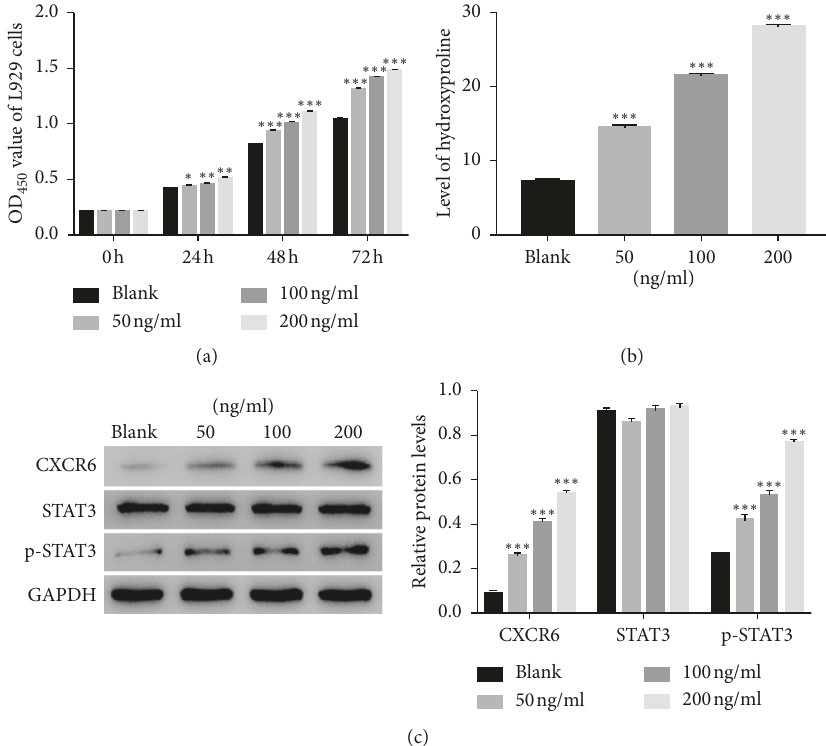
Figure 4: The mouse recombinant protein of CXCL16 contributed to the growth of mouse LF cells. (a) Cell proliferation was detected at 0, 24, 48, and 72hours after being cultured by mouse recombinant protein CXCL16 with different concentration as indicated ( ∗ p < 0 . 05 vs Blank, ∗∗ p < 0 . 01 vs Blank, ∗∗∗ p < 0 . 001 vs Blank). (b) The production of HYP was promoted in mouse LF cells that were cultured by mouse recombinant protein of CXCL16 with different concentrations as indicated ( ∗∗∗ p < 0 . 001 vs Blank). (c) The protein level of CXCR6, STAT3, and p-STAT3 was increased by the protein of CXCL16 in mouse LF cells as indicated ( ∗∗∗ p < 0 . 001 vs